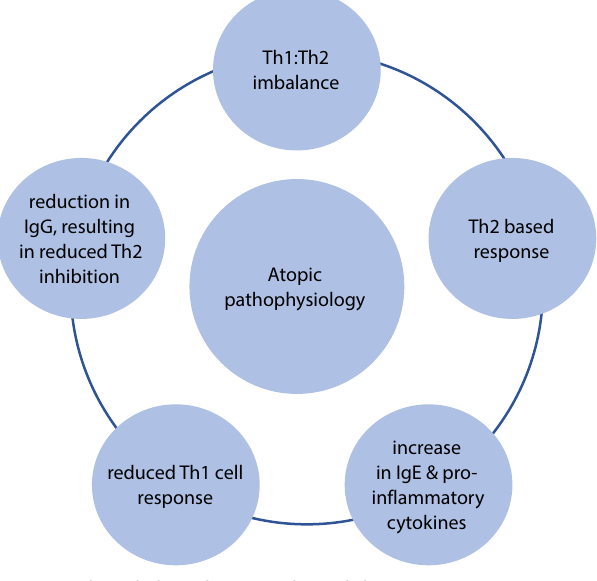
Figure 1: The imbalance between Th1 and Th2.